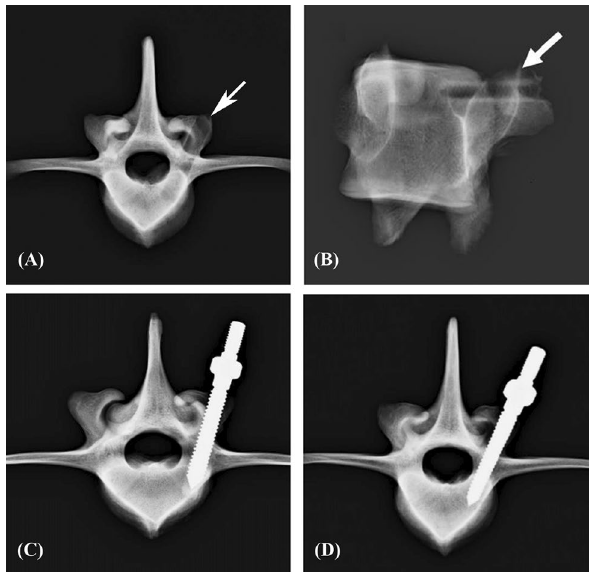
Figure 1. X-ray images of the traditional group. An enlarged screw hole was created and confirmed using axial ( A ) and sagittal X-ray ( B ) images prior to implantation (white arrow). A cylindrical ( C ) or conical ( D ) repair screw was convergently inserted into the 5.5 mm diameter enlarged screw hole after it was filled with PMMA. The tip of the inserted screw did not exceed the enlarged depth, and no signs of fracture or damage were detected in the